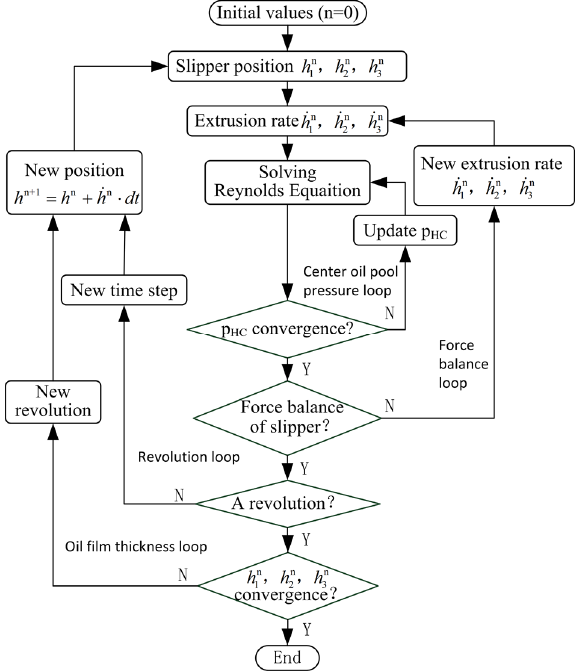
Figure 7. Coupling algorithm block diagram of lubrication model.